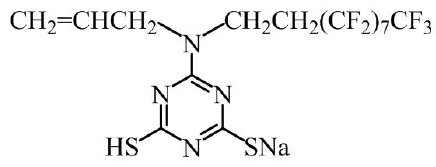
Figure 7. Structure of AF17N